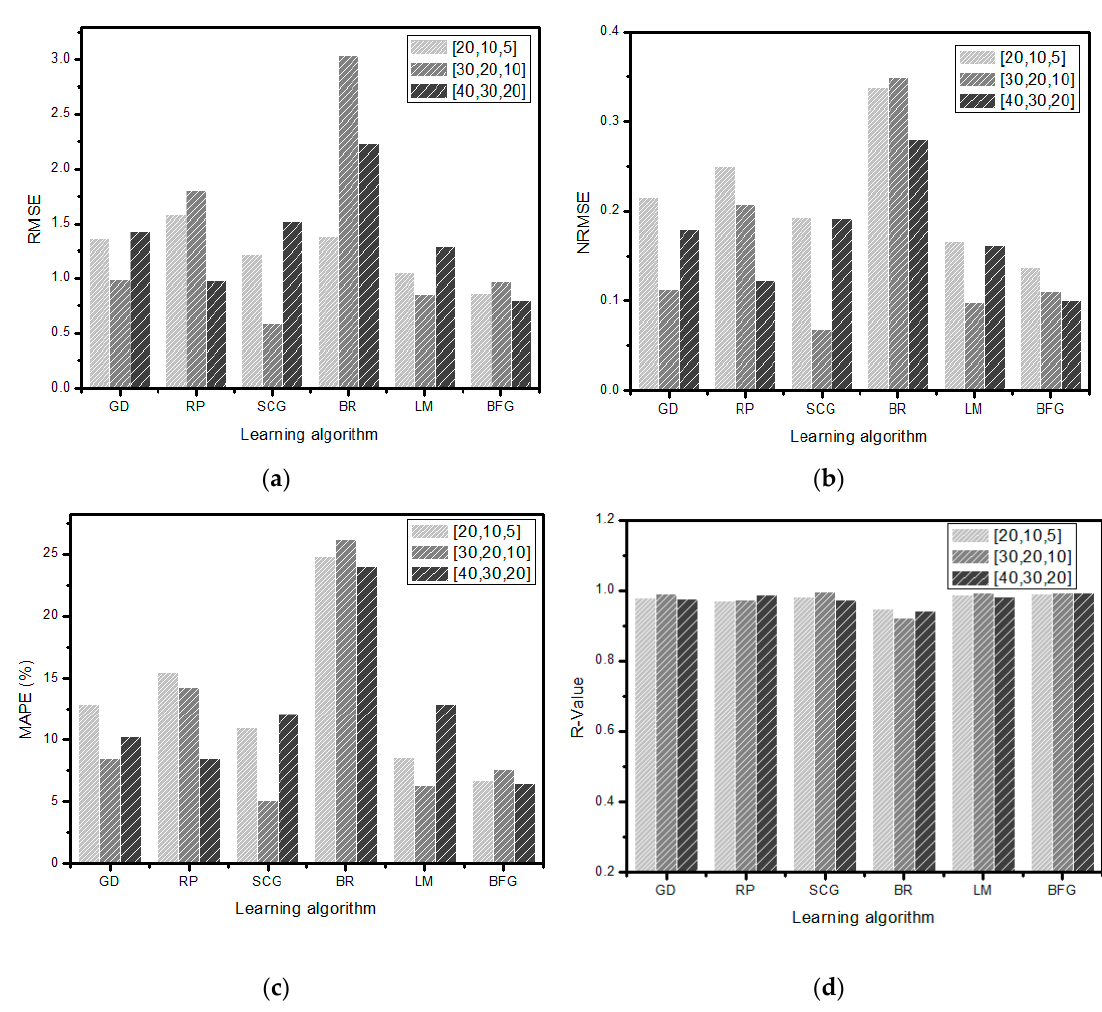
Figure 11. Performance parameters comparison of the different learning algorithms based on changes in the number of neurons and using three hidden layers. ( a ) RMSE; ( b ) NRMSE; ( c ) MAPE (%); ( d ) R value.